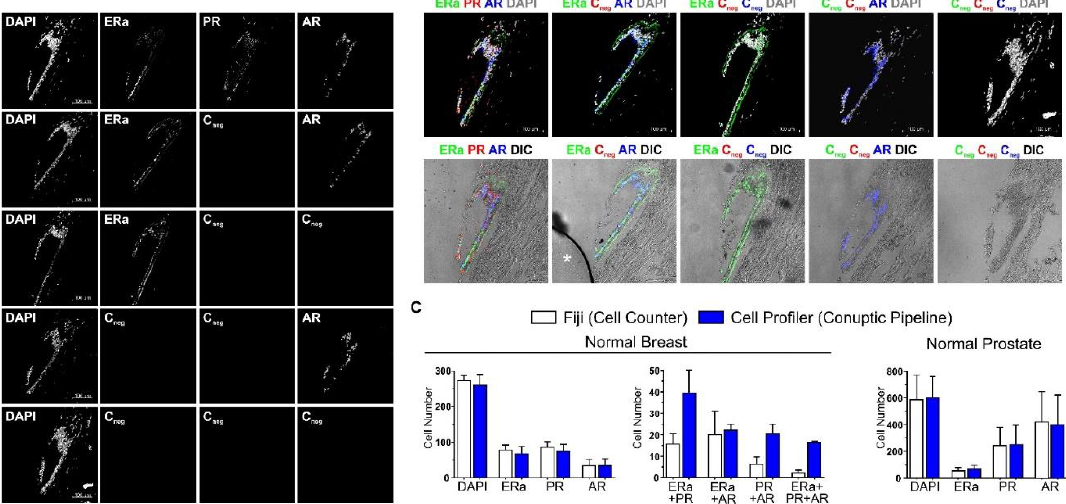
Figure 1. ColNu mIHCF for nuclear hormone receptors with negative controls for each cycle. ( A ) Confocal maximal projections after sequential staining for ERa, PR, and AR in normal breast tissue performed on one slide while omitting one or all primary antibodies (Cneg) in parallel slides. ( B ) Overlay of the channels with DAPI (top) or phase contrast (DIC, bottom). * white asterisk indicates air bubble in the mounting medium. Scale bar shown in DAPI channel. ( C ) Quantification using Fiji or a designed pipeline with Cell Profiler. No differences were found in single channels in normal breast or prostate. Cell profiler was more sensitive for double or triple colocalization. The order of antibodies in the consecutive cycles is indicated above each photograph. Pseudocolor was kept constant: green for the 1st, red for the 2nd, and blue for the 3rd cycle. DAPI was included in the mounting medium and reveals the nuclei. DIC is a plane obtained with transillumination for differential interfering contrast-Nomarski and reveals tissue structure.